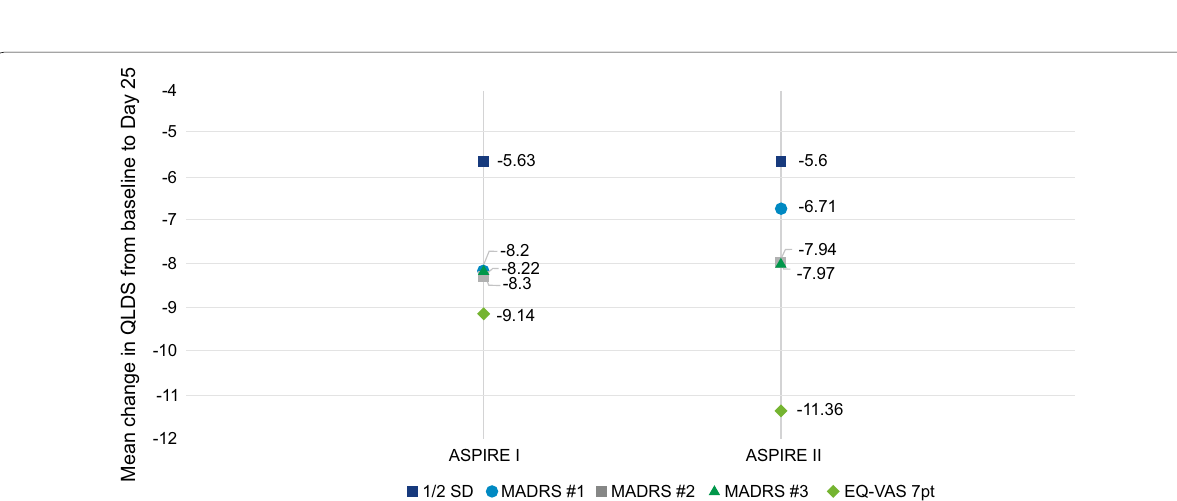
Fig. 3 Meaningful change thresholds of QLDS using anchor- and distribution-based approach. Values represent MCT for various categories or points of improvement in QLDS score from Baseline to Day 25. For all MADRS severity criteria—one-category improvement and for EQ-VAS— 7-point improvement. EQ-VAS EuroQol Visual Analog Scale, MADRS Montgomery–Åsberg Depression Rating Scale, MCT meaningful change threshold; QLDS Quality of Life in Depression Scale, SD Standard